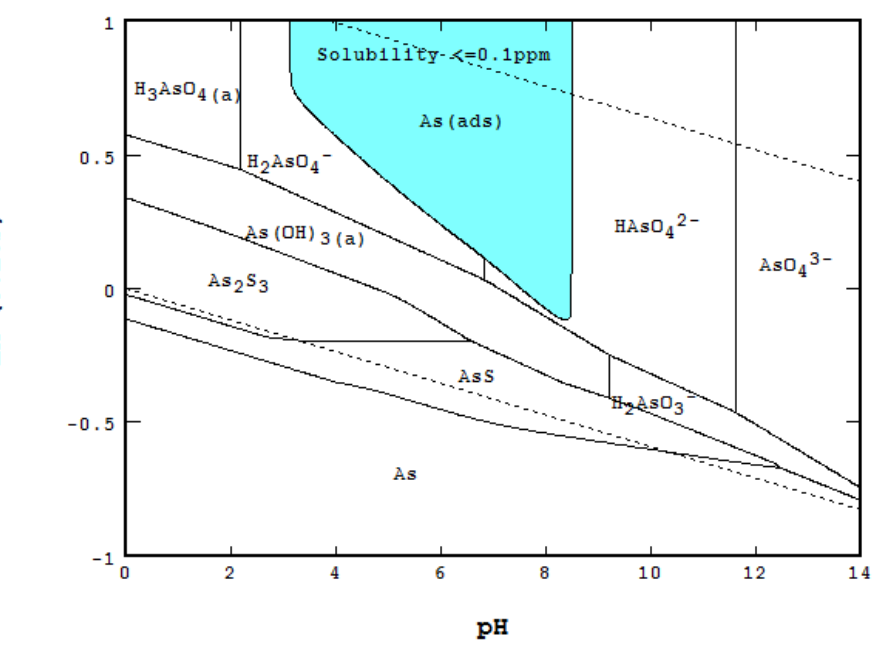
Figure 8. Eh-pH of As–Fe–S water where the mole ratio of Fe/As = 10. The colored area indicates less than 0.1 ppm concentration of As by adsorption.